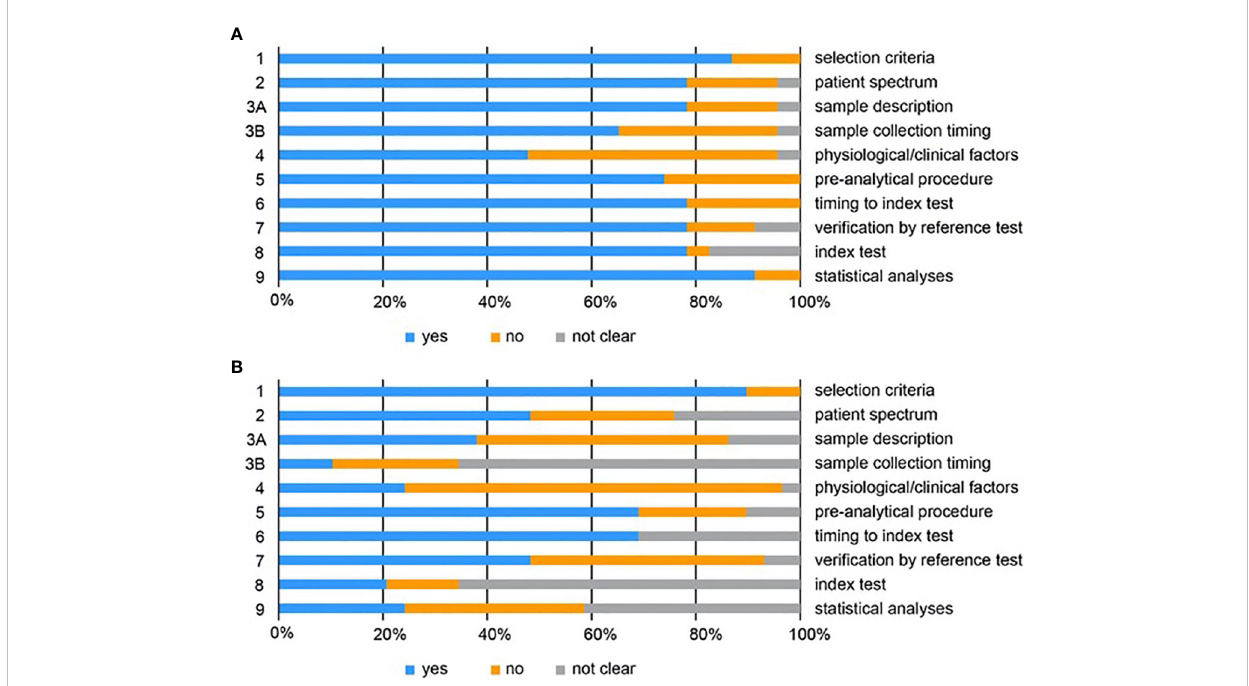
FIGURE 3 QUADOMICS scoring of all studies included for proteomics (A) and metabolomics (B) . Proportion of studies with answers “ yes ” , “ no ” , or “ not clear ” to each of the signalling questions. Each signalling question is numbered on the left and a short description of each question is given on the right. The detailed scoring is given in Supplementary Tables S3 and